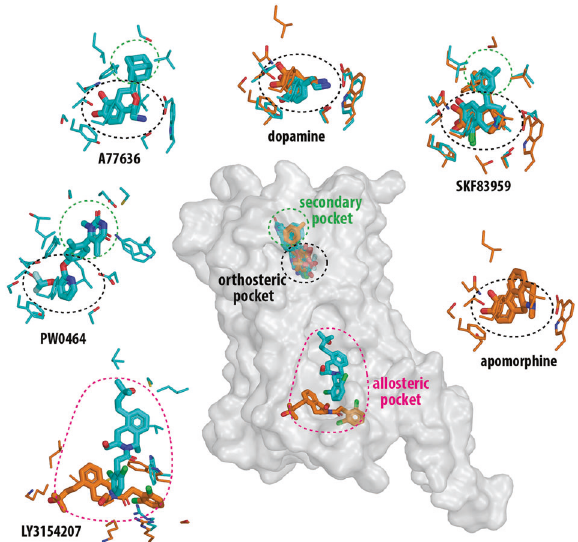
Fig. 1 The DRD1 structures reveal orthosteric, secondary, and allosteric binding pockets. The relative locations of these pockets are indicated by colored ellipses in the central panel in which the active conformation of the DRD1 is shown in a transparent surface representation. The binding poses of selected ligands and their corresponding interacting residues (within 3.8 Å of the ligand) are shown in surrounding panels as labeled. The binding pockets are indicated by the ellipses in the same colors as the central panel. Those from Xiao, et al. 1 are colored in cyan, those from Zhuang, et al. 2,3 are colored in orange. In particular, three pairs of structures bound with dopamine, SKF83959, or LY3154207 from both groups are superimposed to demonstrate their